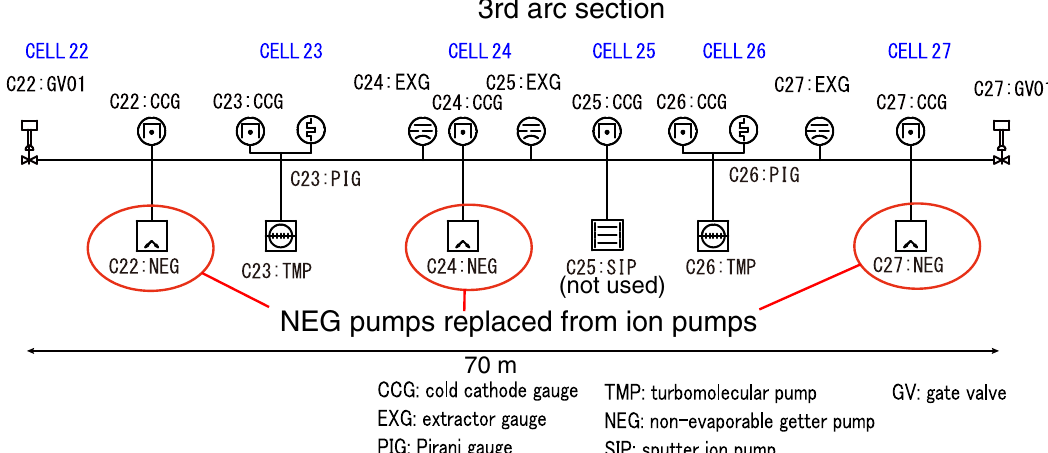
FIG. 23. Layout of the vacuum system for the third arc section, where the NEG pumps are additionally installed. Three NEG pumps are installed in the position of the ion